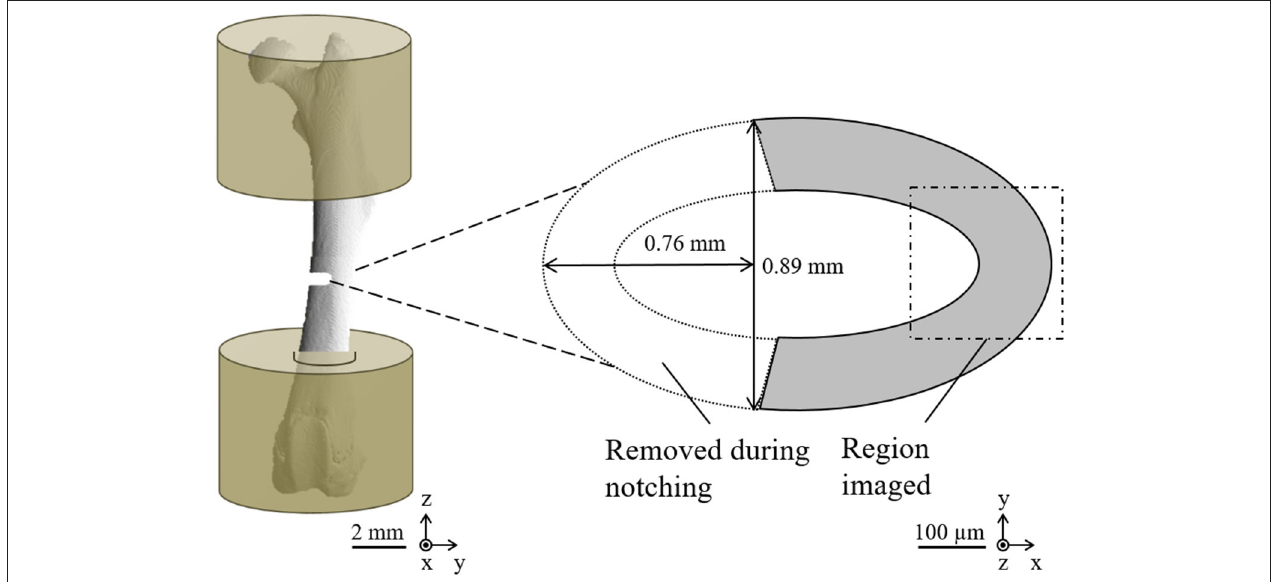
FIGURE 3 | Sample preparation for image-guided failure assessment based on a combination of micro-compression and SR CT imaging. (Left) Schematic drawing of mouse femora embedded in PMMA and notched at the mid-diaphysis. (Right) A cross-sectional sketch, showing the volume of interest for SR CT